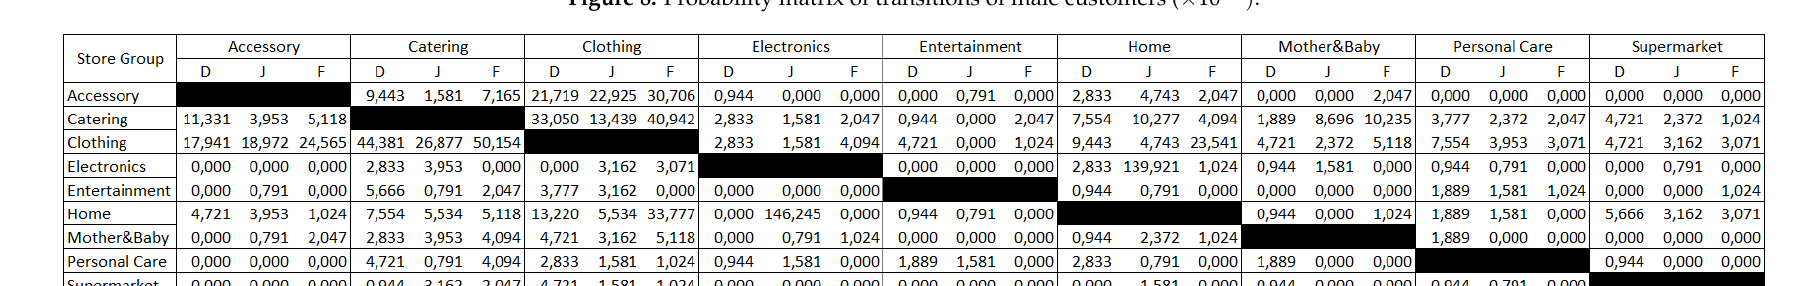
Figure 8. Probability matrix of transitions of male customers ( × 10 − 3 ) .